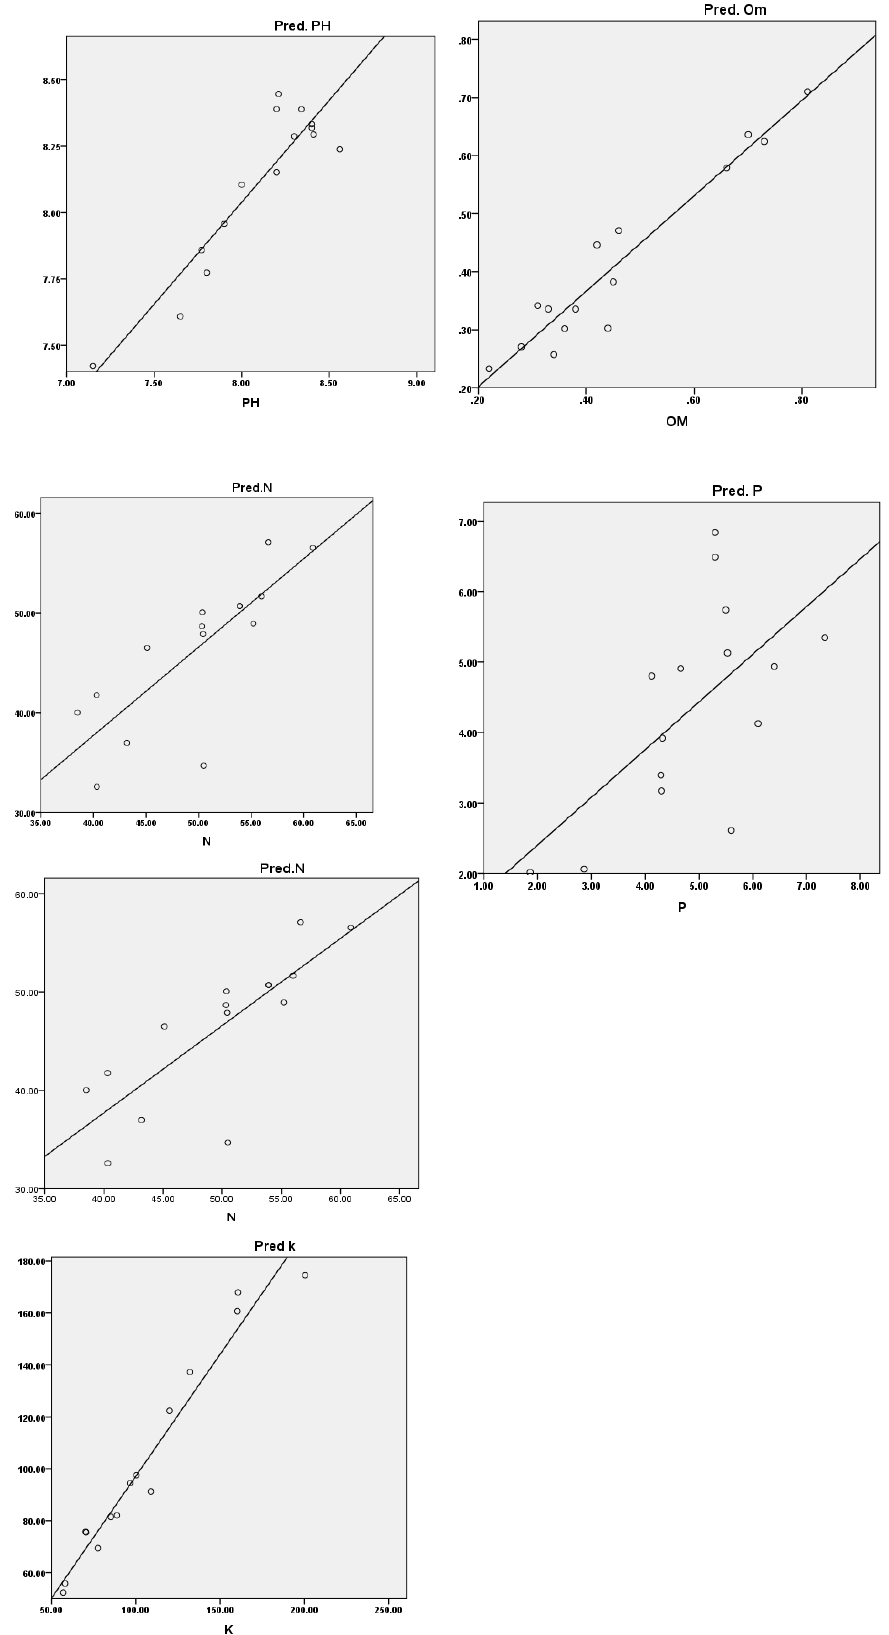
Figure 11. Linear correlation between measured and predicted parameters.